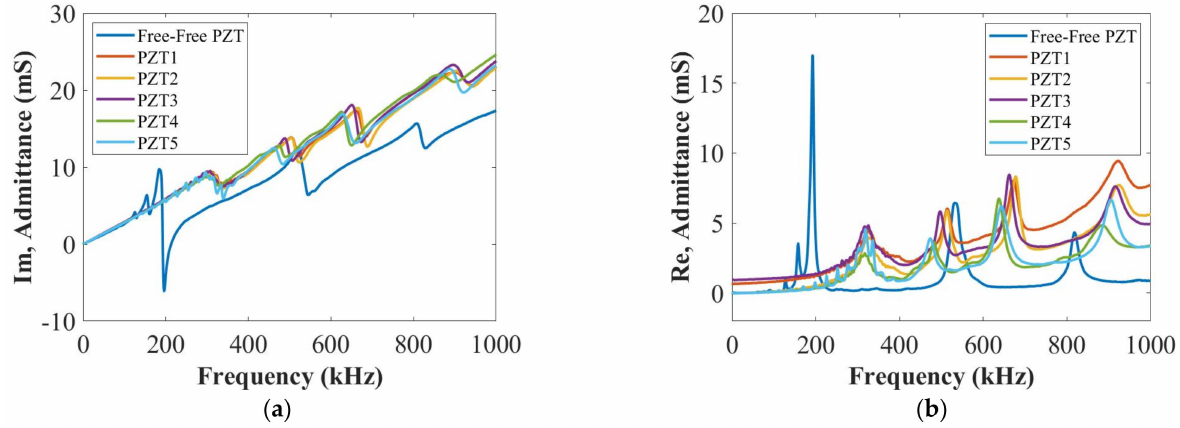
Figure 3. The EMI results of ( a ) imaginary and ( b ) real part of admittance for different PZT